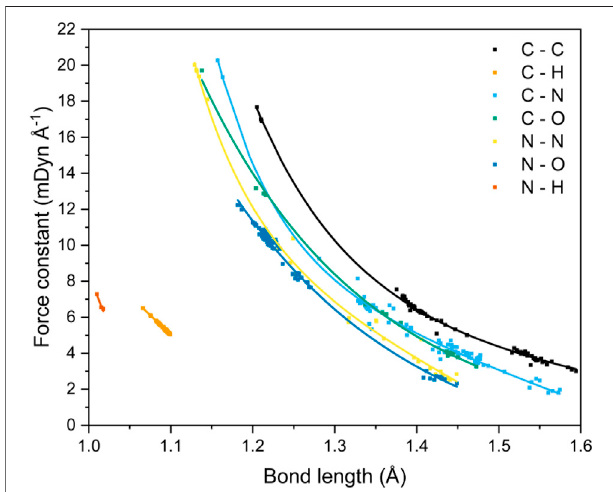
FIGURE 5 | Correlation between bond lengths and local vibrational mode force constants for seven covalent bonding